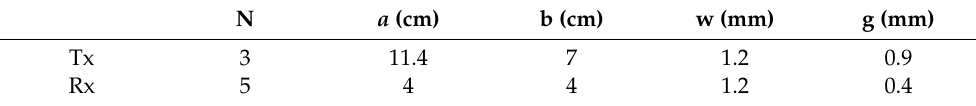
Table 3. Dimensions of the obtained coils using the proposed FOM optimization method.